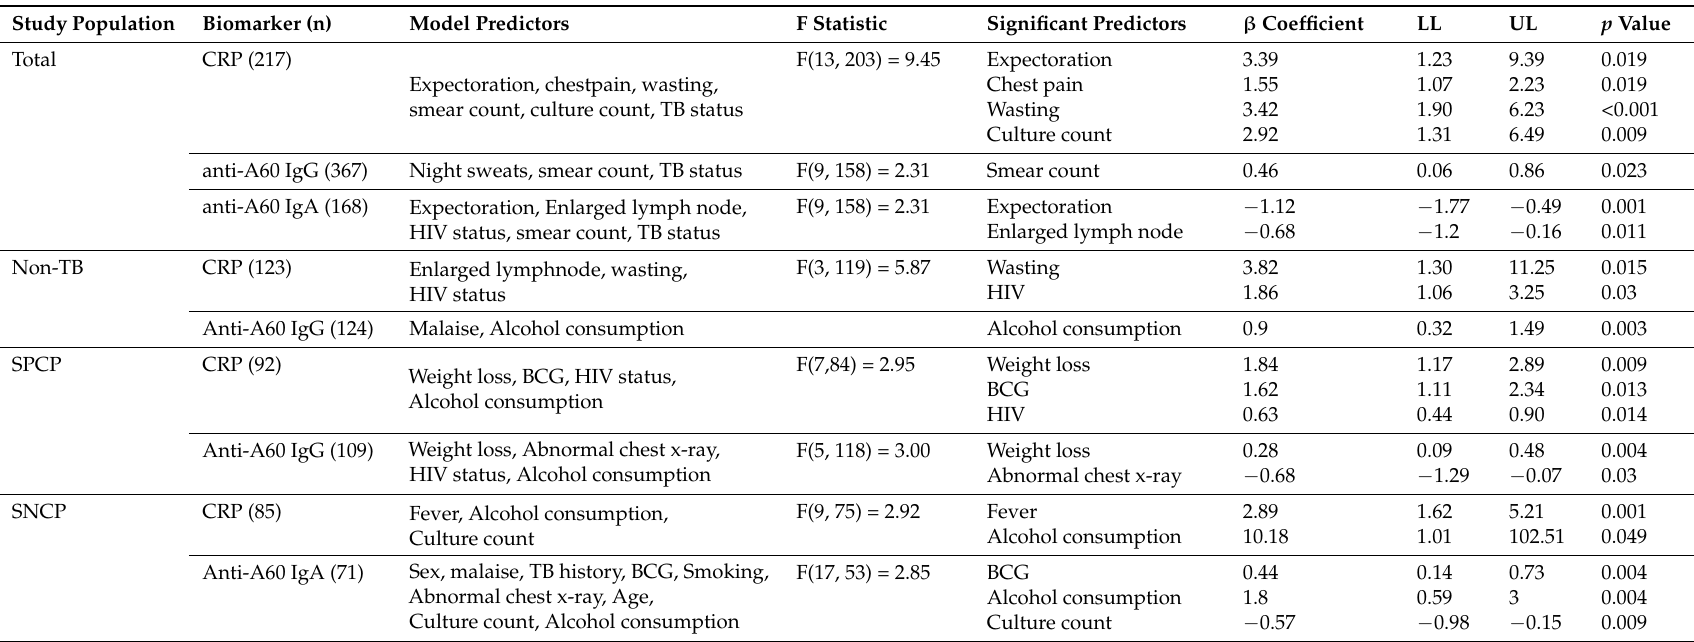
Table 2. Regressions to predict biomarkers with host